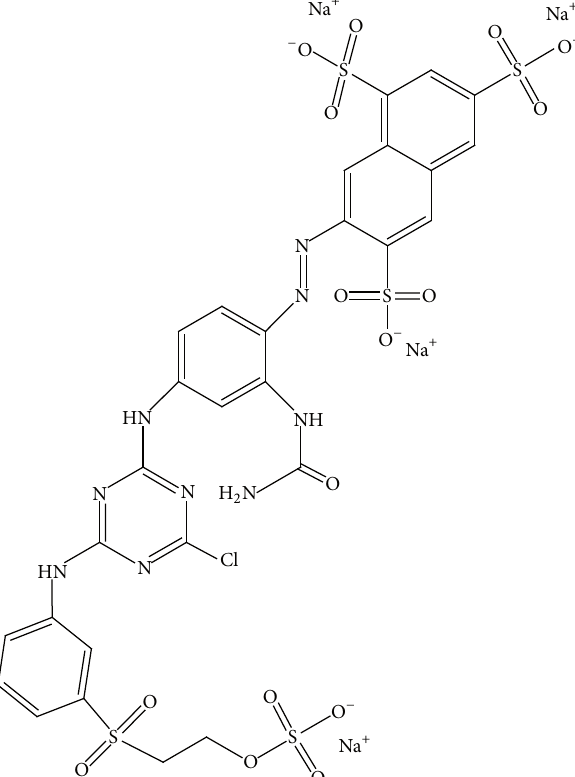
S 1: e structure formula of